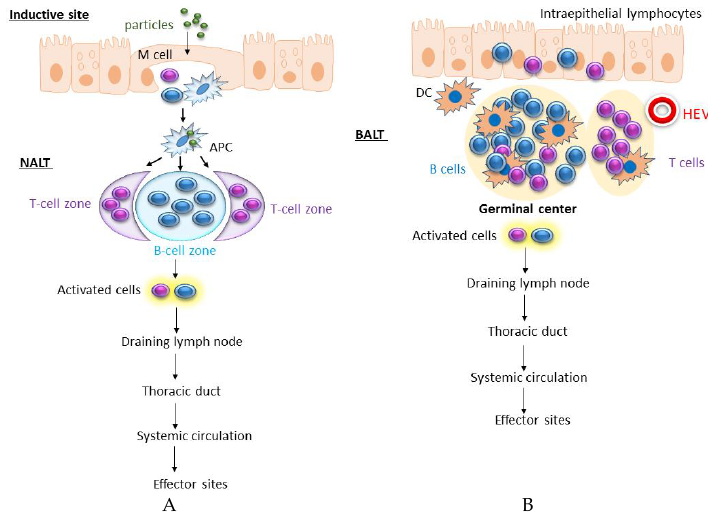
Figure 1. The nasal-associated lymphoid tissue (NALT) and bronchus-associated lymphoid tissue (BALT). ( A ) The NALT contains many lymphoid follicles (B cell areas), interfollicular areas (T cell areas) and antigen-presenting cells (APCs, macrophages and dendritic cells). The epithelium forming the NALT comprises ciliated epithelial cells, goblet cells and non-ciliated cells similar to the M-cells. Activated T and B cell are transported to the draining lymph nodes (dLNs) by efferent lymphatics draining and from the dLNs to the effector sites; ( B ) BALT is less organized than NALT and is located mostly at bifurcations of the bronchial tree. BALT is a structure with T cell and B cell areas, high endothelial venules (HEV) in the T cell zone and an overlying lymphoepithelium containing cells similar to the microfold cells (M). It is composed of undifferentiated macrophages and lymphocytes in a loose stromal network, with an epithelium lacking of the goblet cells and